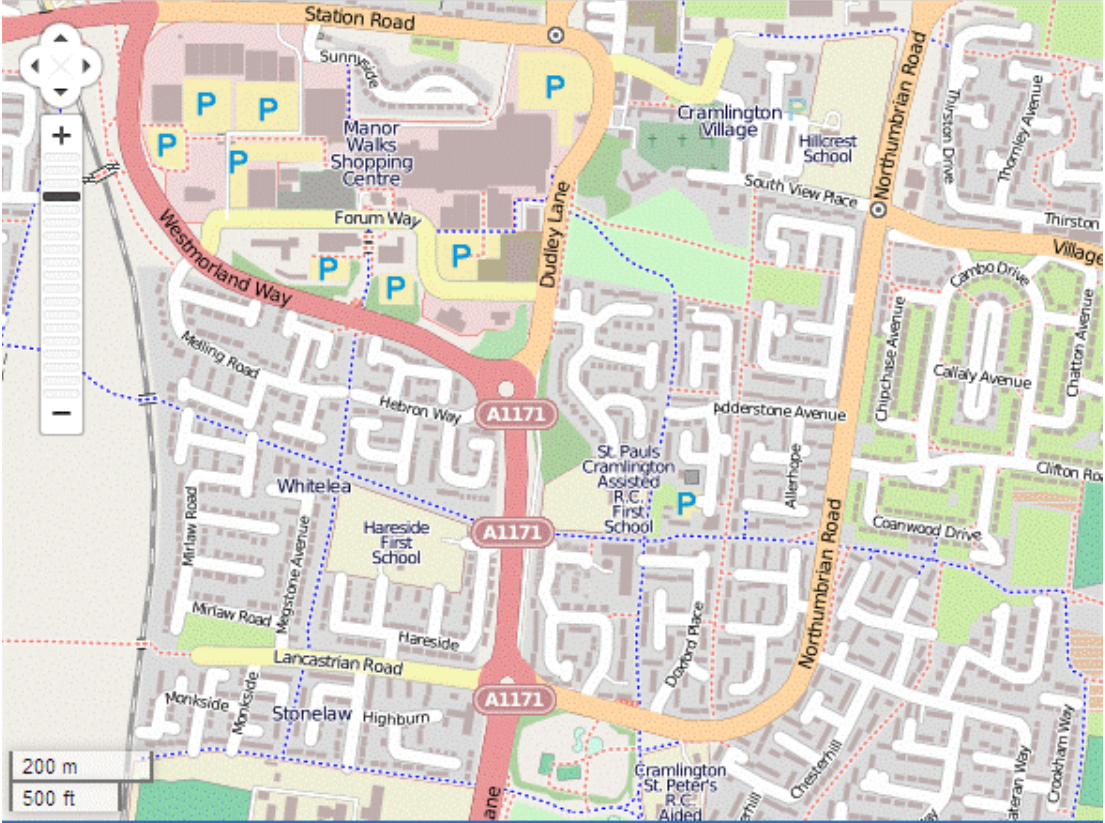
Figure 1. OpenStreetMap representation of the study area at Cramlington.